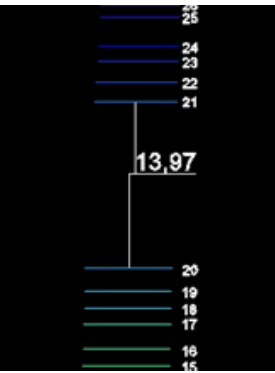
Figure 8. Deviations in the vertical direction from top to bottom of balcony.